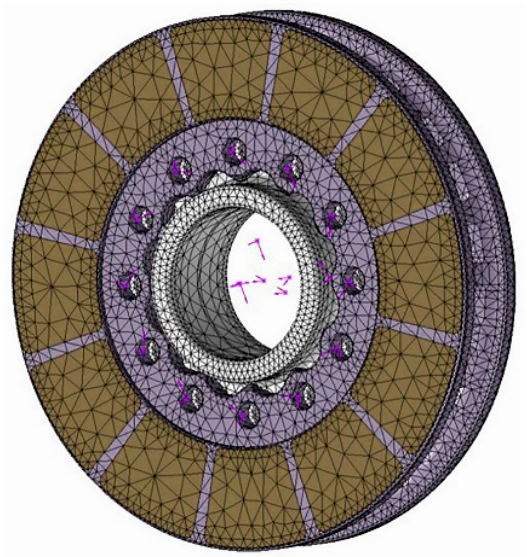
Figure 6. Meshing of the 3D thermal-stress calculation model.